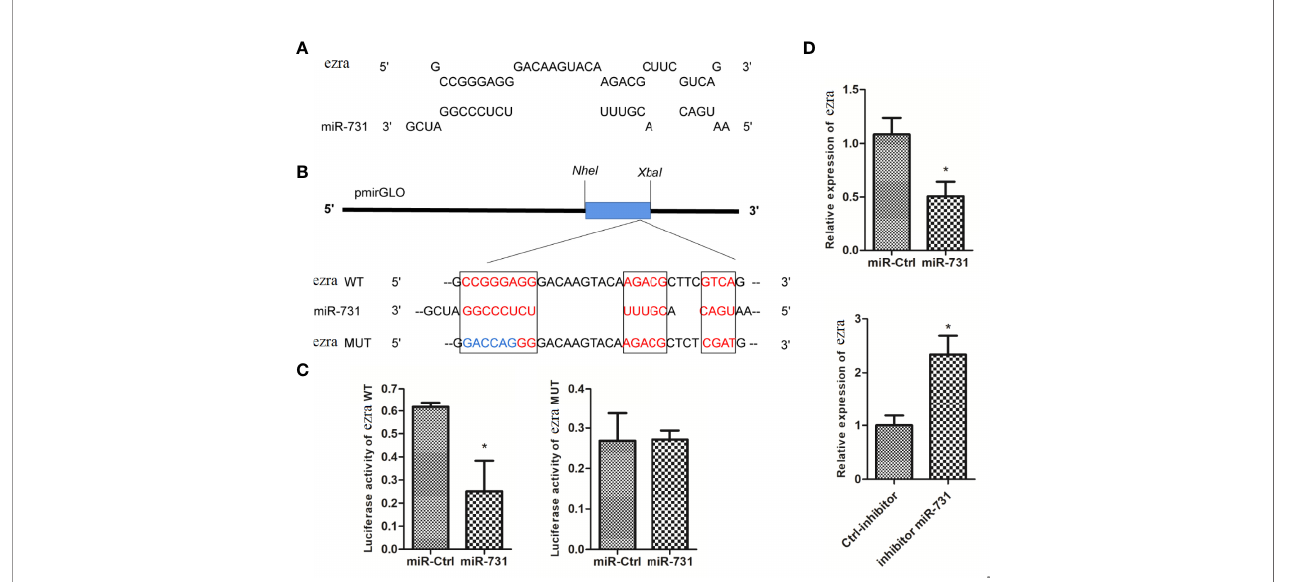
FIGURE 4 | Prediction and validation of target genes of miR-731. (A) Binding site of miR-731 and ezra . (B) Schematic diagram of the NheI/Xbal sites. (C, D) C. idella Kidney cells (CIK) were transfected with miR-731 agomir or control solution, along with the recombinant plasmids pmirGLO-ezra-WT or pmirGLO-ezra-MUT for 24 h, and the luciferase activity was determined. All values represent the mean ± SD of three independent experiments. Asterisks indicate signi fi cant differences (*p <